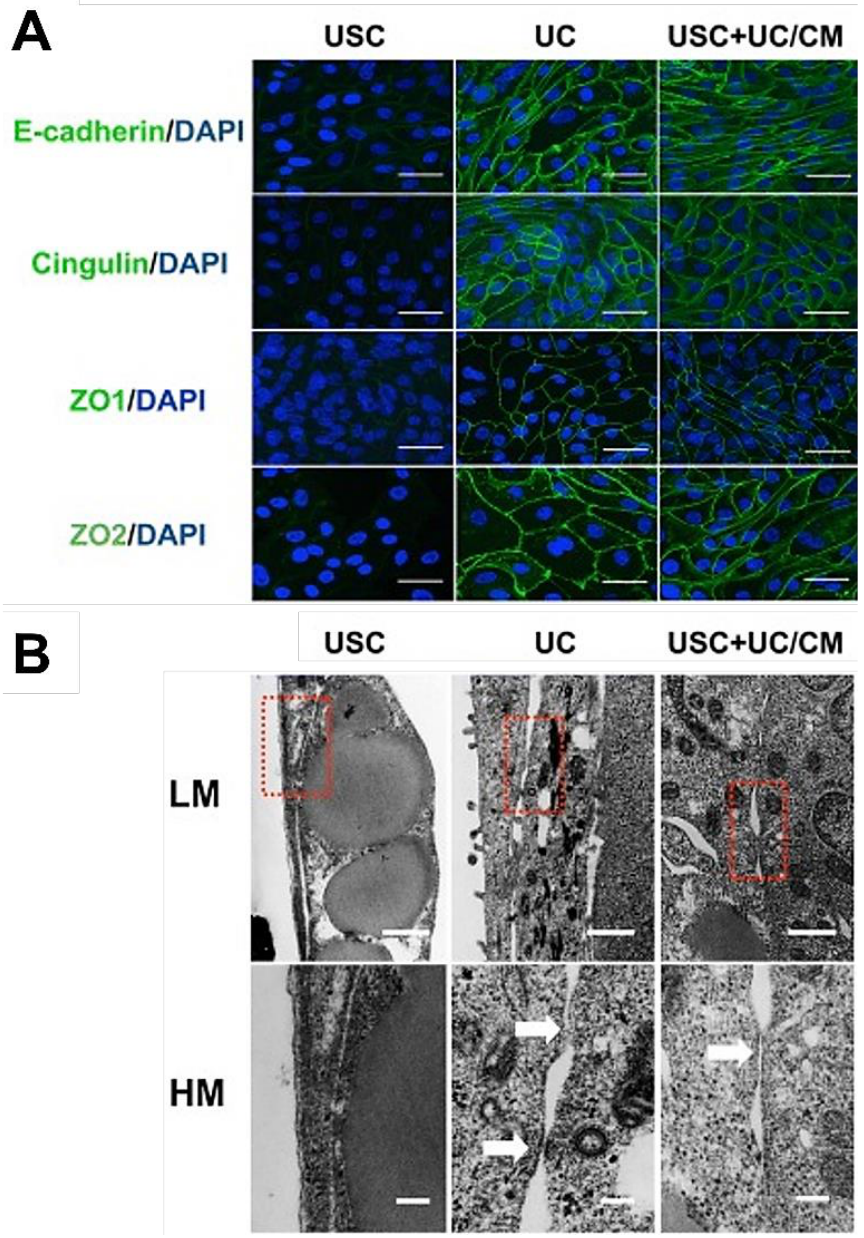
Figure 3. The formation of cellular junctions between urothelial induced USC. ( A ) Images of immunofluorescent staining indicated the comparable formation of tight junctions with stained markers (E-cadherin, Cingulin, ZO1, and ZO2) in both UC and urothelial differentiated USC, but not in USC alone. Scale bar = 40 μM. ( B ) Tight junctions and desmosomes were observed in the intercellular space of both UC and urothelial differentiated USC, whereas not found in USC alone through TEM. The red dashed box and white arrows indicate tight junctions and desmosomes. LM scale bar = 500 nm, HM scale bar = 100 nm. Abbreviations: TEM, transmission electron microscopy; USC, urine-derived stem cells; UC, urothelial cells; UC/CM, urothelium conditioned medium. Images are adapted from Stem Cell Res Ther. [56] with permission. (License link: http://creativecommons.org/licenses/by/4.0/ accessed on 13 April 2022).